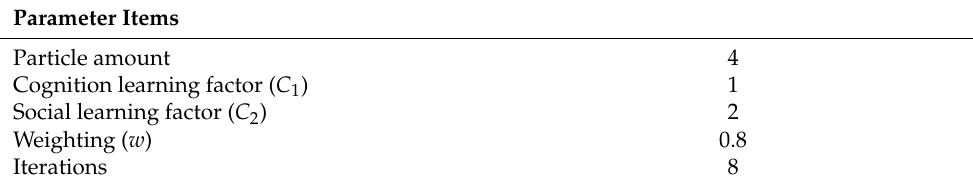
Table 1. PSO parameter